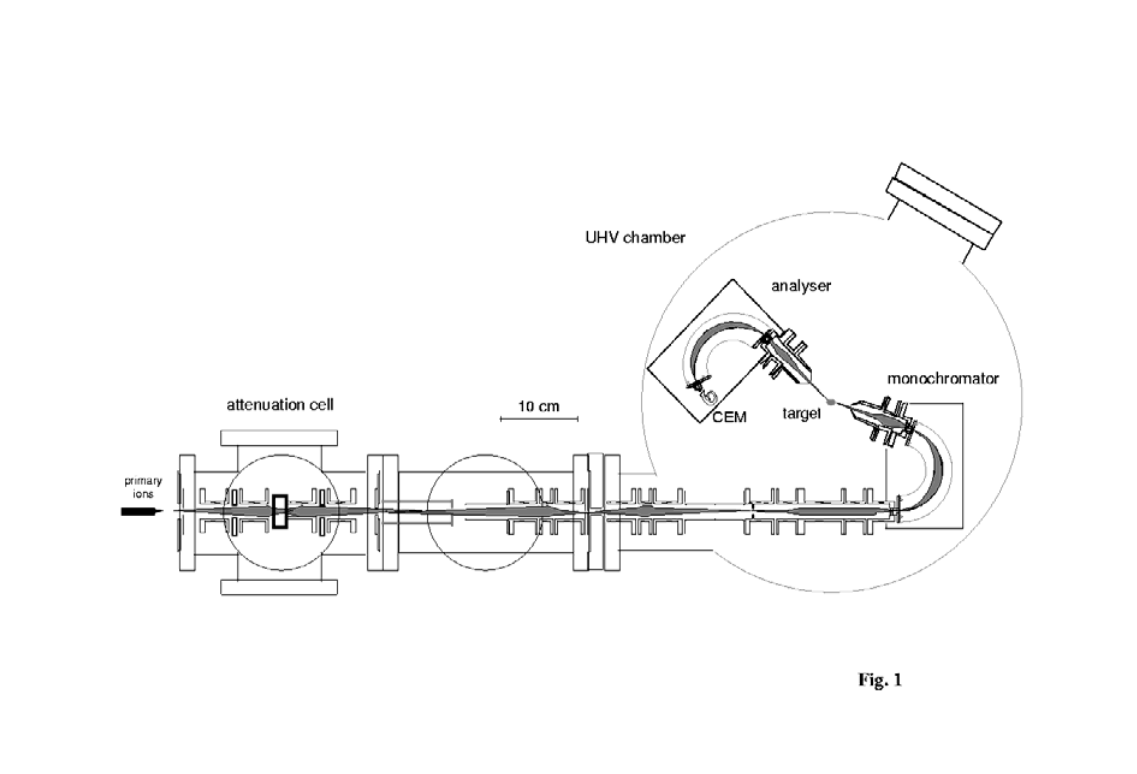
Fig. 1 : Schematic view of the translational energy spectrometer with attenuation cell in front. Discussion of experimental